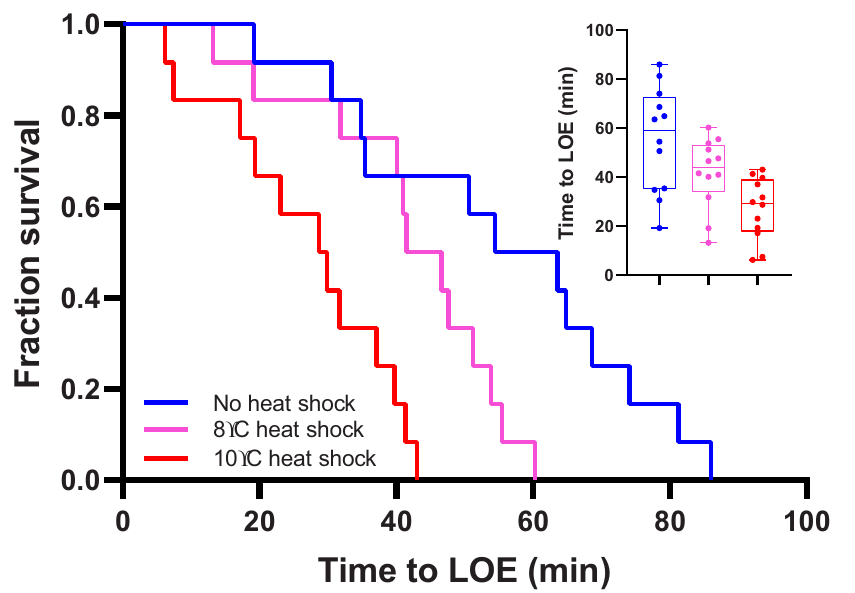
Fig 1. Survivorship curves and time to loss of equilibrium (LOE) in Bellapiscis medius exposed to severe hypoxia (7% air saturation) after 19 h recovery from acute heat shock. Blue line = control group (no heat shock), pink line = +8˚C heat shock (21–29˚C), red line = +10˚C heat shock (21–31˚C). Inset shows median time to loss of equilibrium and individual data points (N = 12 per treatment group). Different lower case letters in the inset indicate significant differences (P < 0.05) in the median time to LOE among treatment